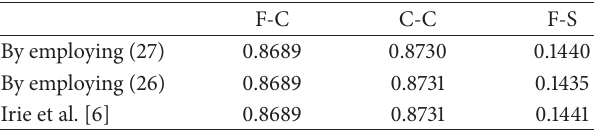
Table 3: Natural frequency parameters obtained by employing (26) and (27) ( 𝑛 = 0 , 𝑚 = 0